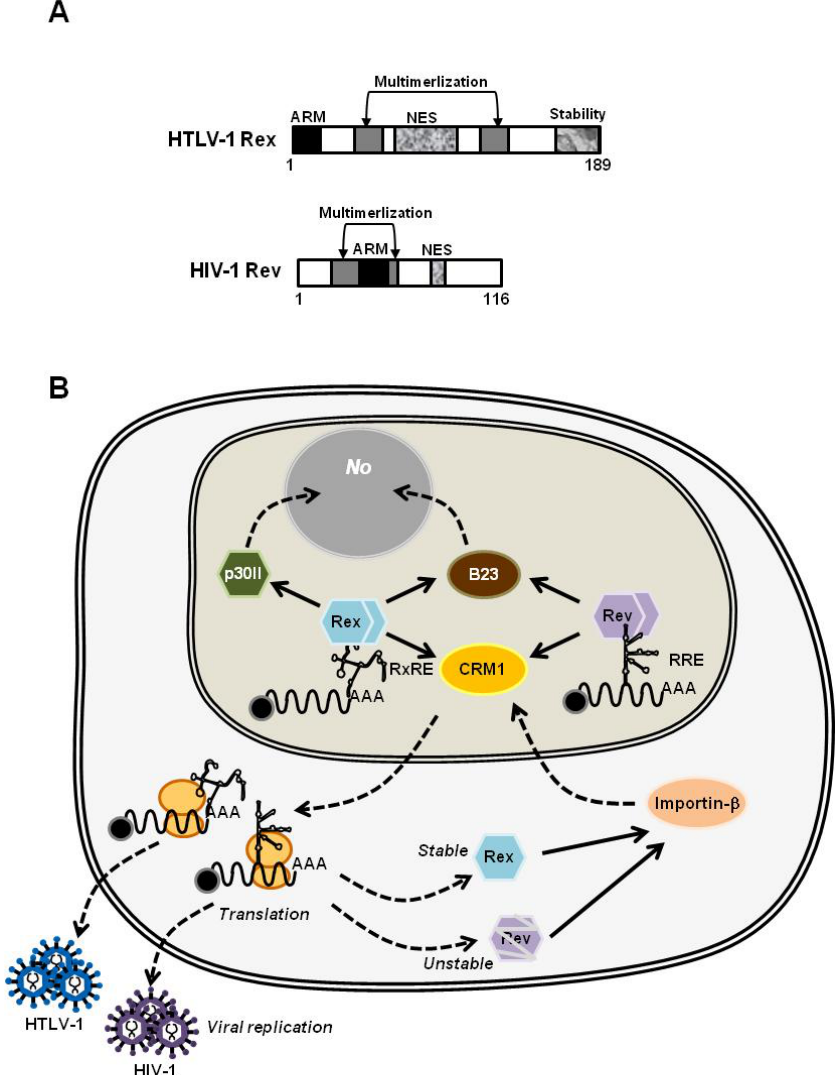
Figure 4. ( A ) The primary structures of HTLV-1 Rex and HIV-1 Rev. The homology in the primary sequences of HTLV-1 Rex and HIV-1 Rev is low, but they share most of the functional domains critical for their function, i.e. , arginine-rich RNA binding domain, NLS, NES, and two multimerization domains; ( B ) HTLV-1 Rex and HIV-1 Rev play similar functions through similar mechanisms. In the nucleolus, Rex and Rev specifically bind to the respective viral mRNAs through Rex responsive element (RxRE) for Rex and the Rev responsive element (RRE) for Rev. They stabilize unspliced or partially-­‐‑spliced viral mRNA and actively transport these to the cytoplasm for selective translation of viral structural proteins by CRM1 binding through their NES. Rex and Rev return to the nucleus by binding to Importin-­‐‑β, and further translocated to the nucleolus (No) by binding to B-­‐‑23 via NLS.